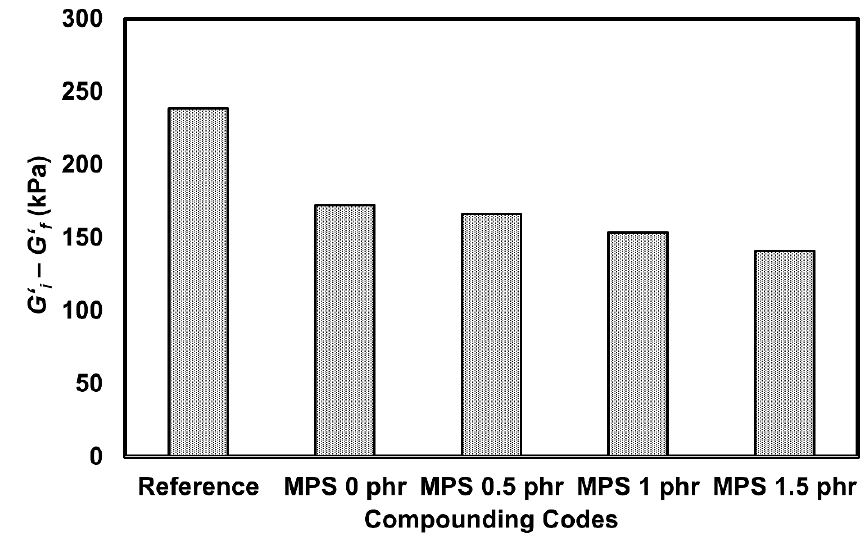
Figure 9. Payne effect ( G’ i – G’ f ) of NR/HNT composites in the presence of MNR/MPS as a dual compatibilizer.